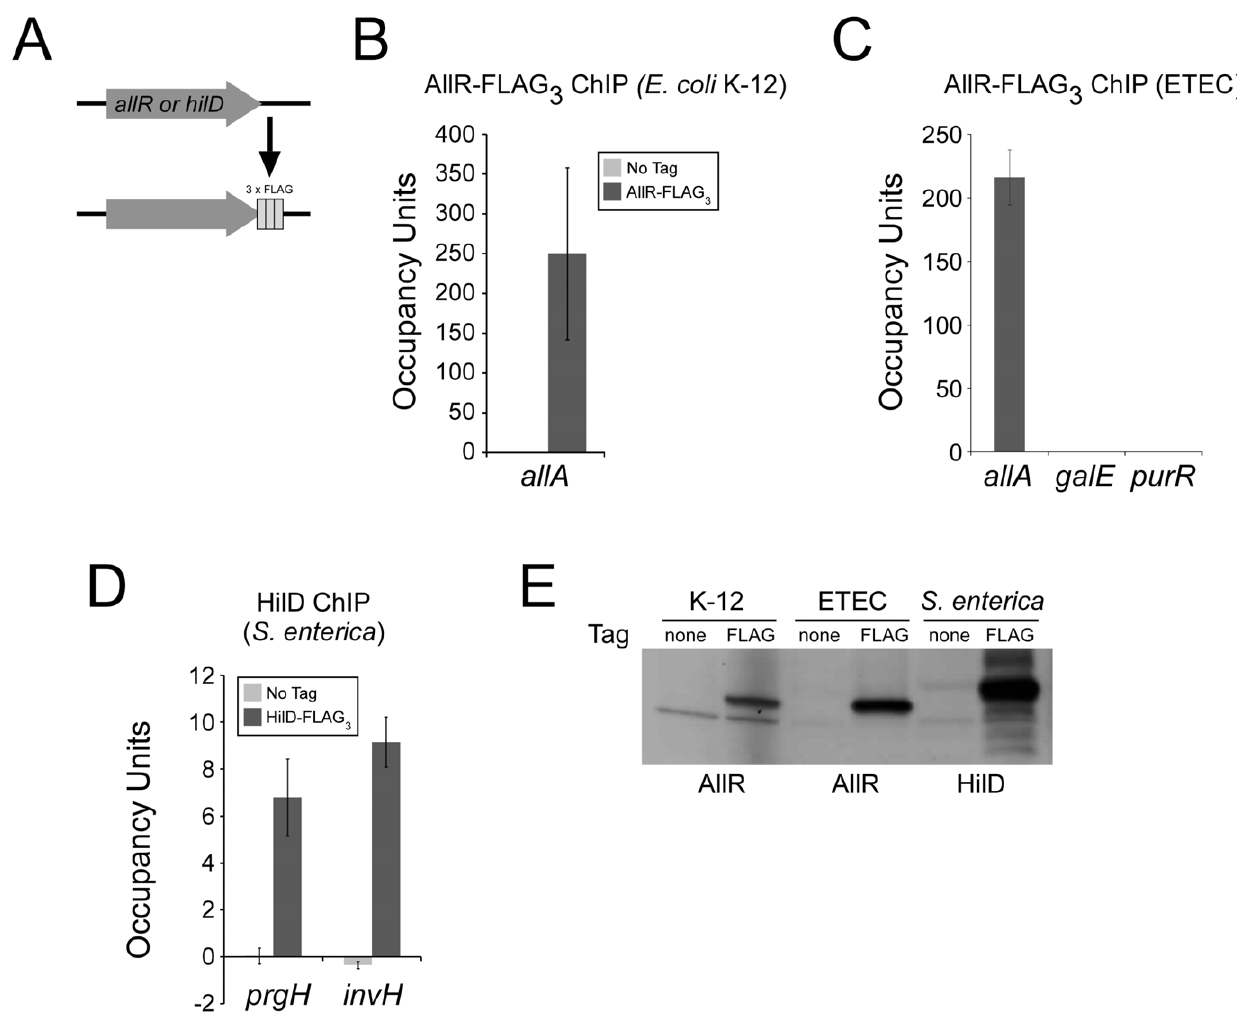
Figure 3. FRUIT epitope-tagging of MG1655 ( E.coli K-12) allR , H10407 (ETEC) allR , and 14028s ( S.enterica serovar Typhimurium) HilD. (A) Schematic indicating C-terminal tagging with three FLAG tags. (B) ChIP/qPCR assay to measure association of MG1655 AllR-FLAG 3 with the region upstream of allA (known AllR site in E. coli K-12) [32]. Values are also shown for a control ChIP with an untagged strain. Occupancy unit values represent background-subtracted enrichment relative to a control region. (C) ChIP/qPCR assay to measure association of H10407 AllR-FLAG 3 with the region upstream of allA , or with predicted non-target regions upstream of galE and purR . Occupancy unit values represent background-subtracted enrichment relative to a control region. (D) ChIP/qPCR assay to measure association of 14028s HilD-FLAG 3 with the regions upstream of prgH and invH (known HilD targets) [33]. Values are also shown for a control ChIP with an untagged strain. Occupancy unit values represent background- subtracted enrichment relative to a control region. (E) Western blot probing extracts from untagged and FLAG-tagged strains for MG1655 (K-12), H10407 (ETEC) and 14028s ( S. enterica ). Note that the anti-FLAG antibody cross-reacts with a protein expressed E. coli K-12.